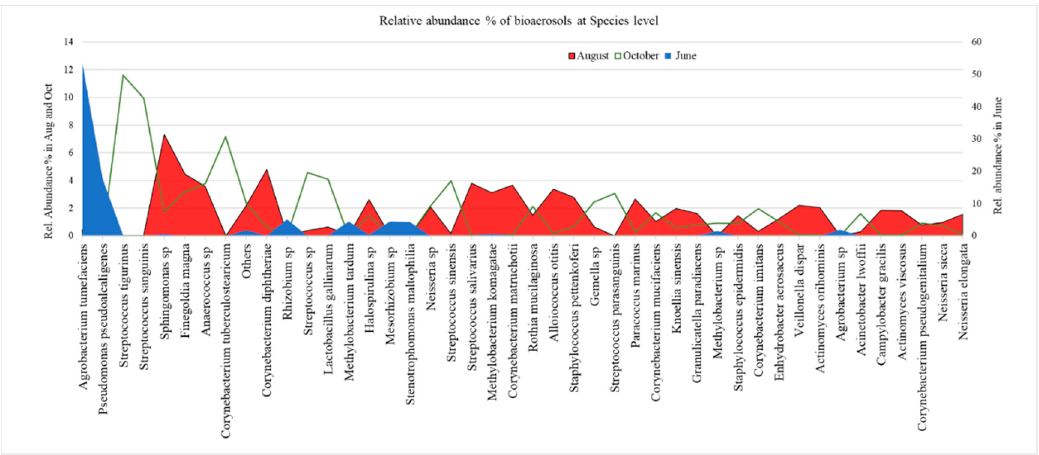
Figure 4. The relative abundance % of bacterial aerosols at the species level in the urban air of Ath-